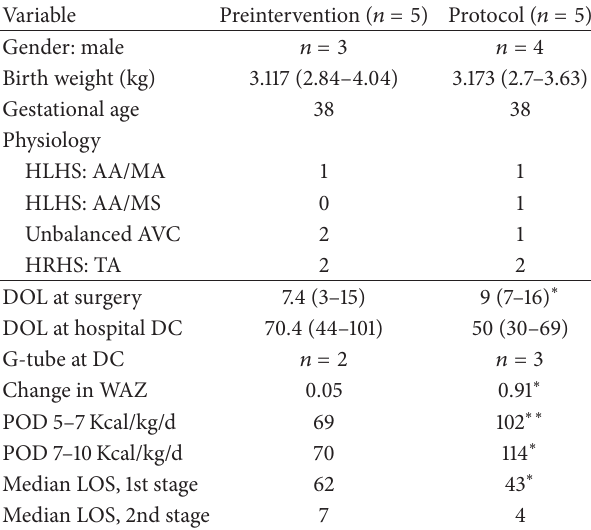
Table 1: Subject characteristics.